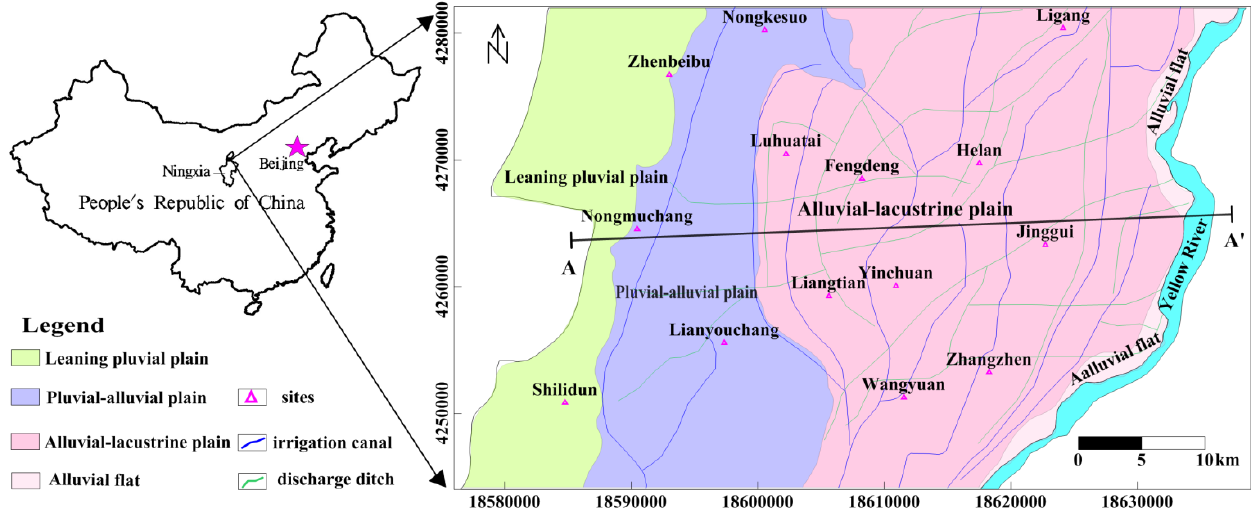
Figure 1. Location of the study area and landforms in Yinchuan, Ningxia Province,